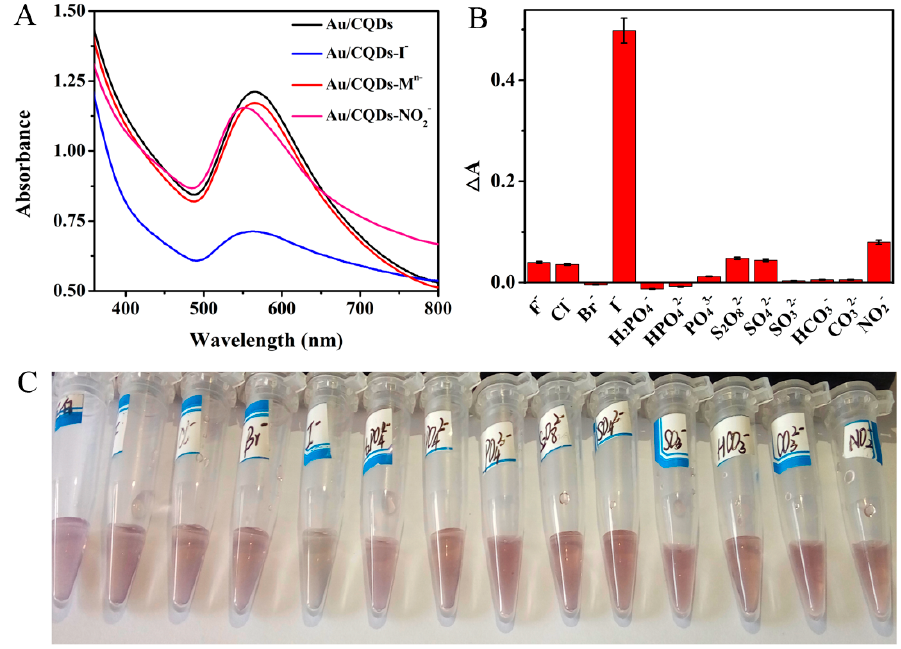
Figure 5. UV–vis absorption spectra ( A ); Δ A ( B ) and photographs ( C ) of proposed sense in the presence of various anion ions (M: F − , Cl − , Br − , H 2 PO 4 − , HPO 42 − , PO 43 − , S 2 O 82 − , SO 42 − , SO 32 − , HCO 3 − , CO 32 − ). The concentrations of all anion ions are 400 μ M.